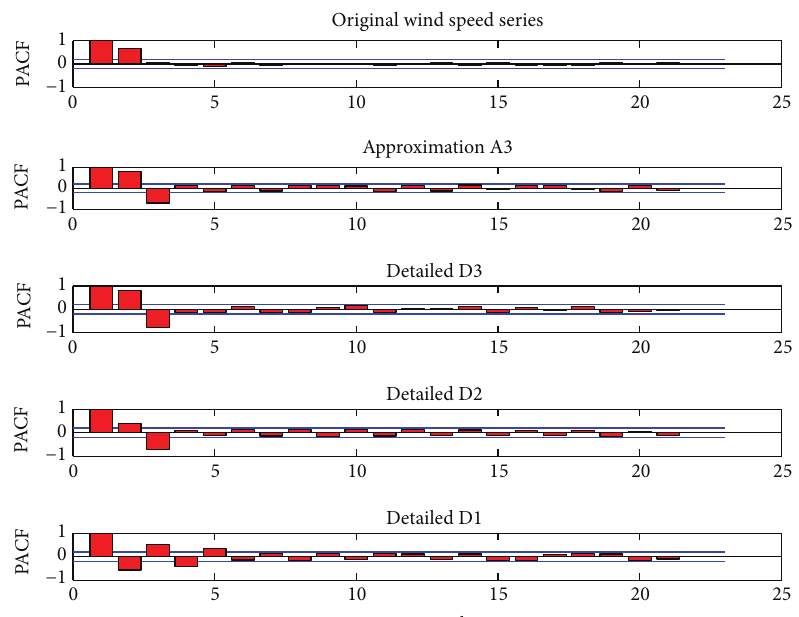
according to Kolmogorov’s theorem, in the modeling of one- hidden-layer neural network, a hidden layer of 2𝑛 + 1 nodes is sufficient to map any function for 𝑛 input [50]. Therefore, for model comparison, the total nodes number of two hidden layers is selected as the 2𝑛 + 1 for 𝑛 input in the modeling process of TNN. In order to further confirm the nodes number in each hidden layer, the experimental simulation